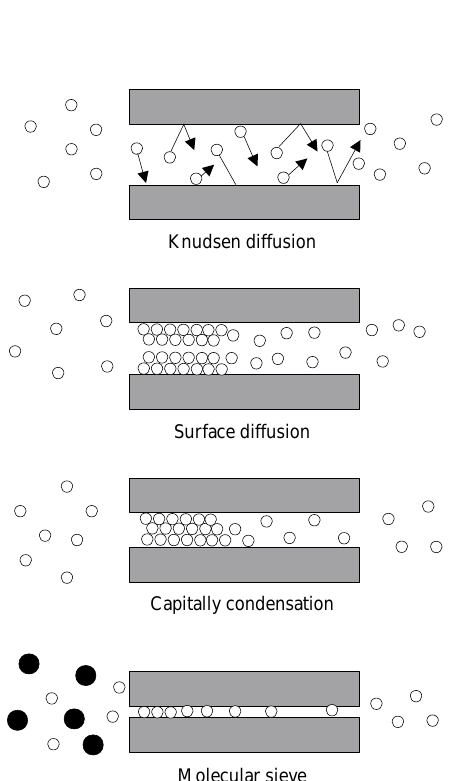
Fig. 2 Permeation model of gas in porous materials (modified from Matsukata